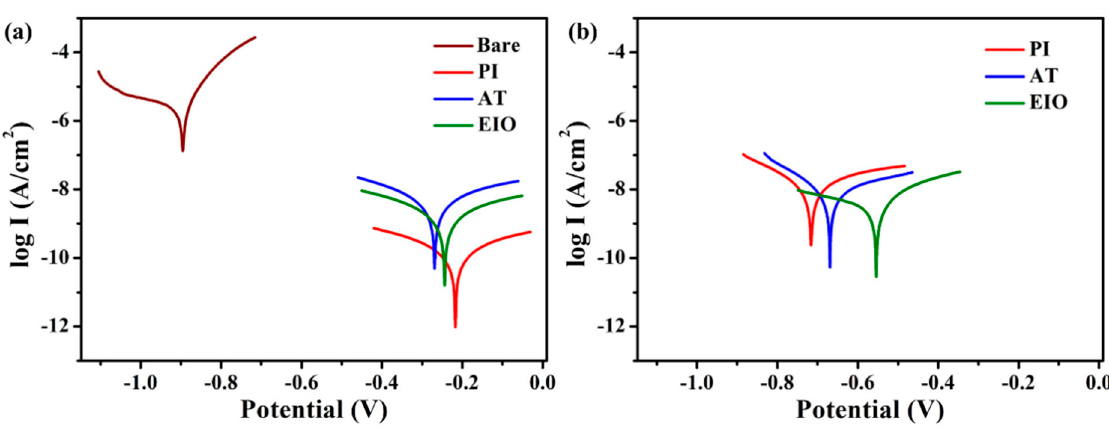
Table 3. Electrochemical parameters derived from Tafel plots of the coatings in the saline solution after 30 days immersion.